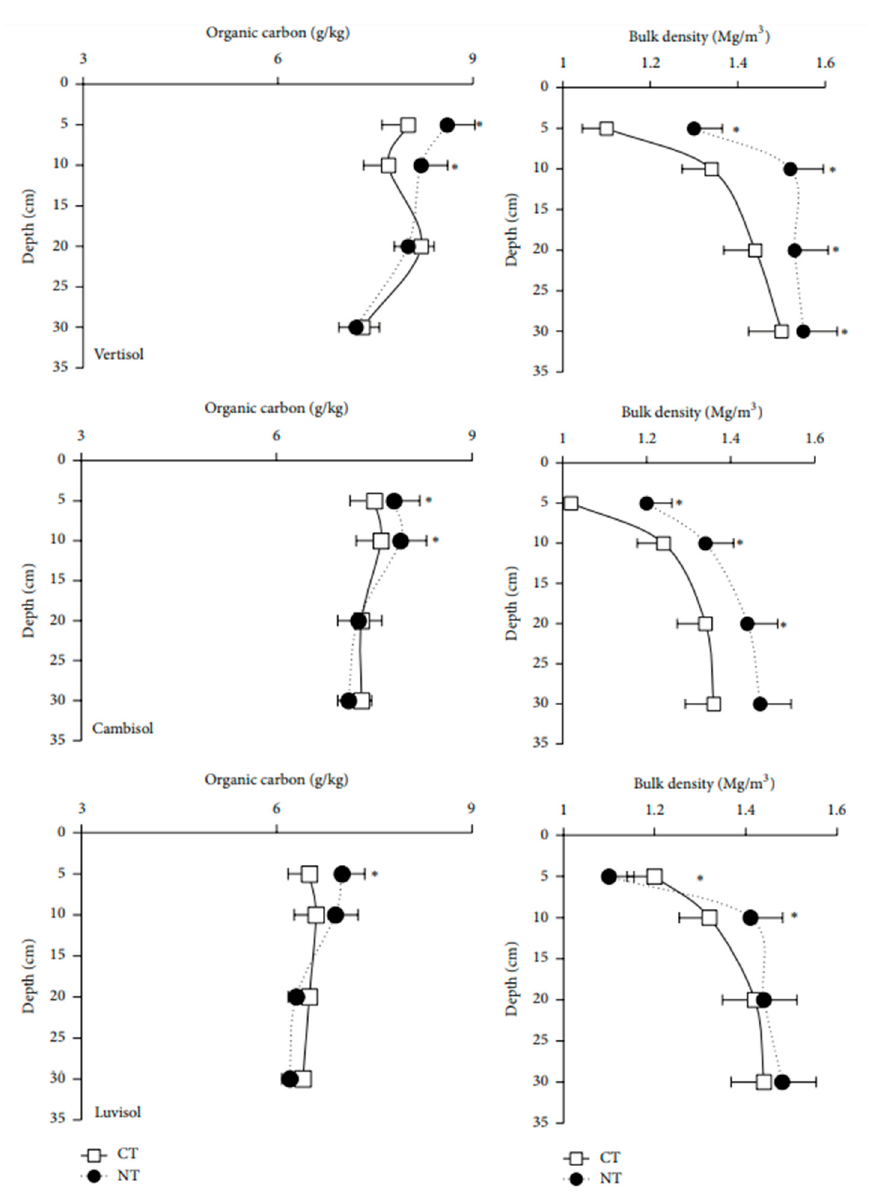
Figure 3. Soil organic carbon content (SOCc) and bulk density (Db) in three soil types after 5 years under NT and CT. At each depth (*) means the presence of significant differences between treatments ( p < 0.05). The error bar represents one standard error [31].